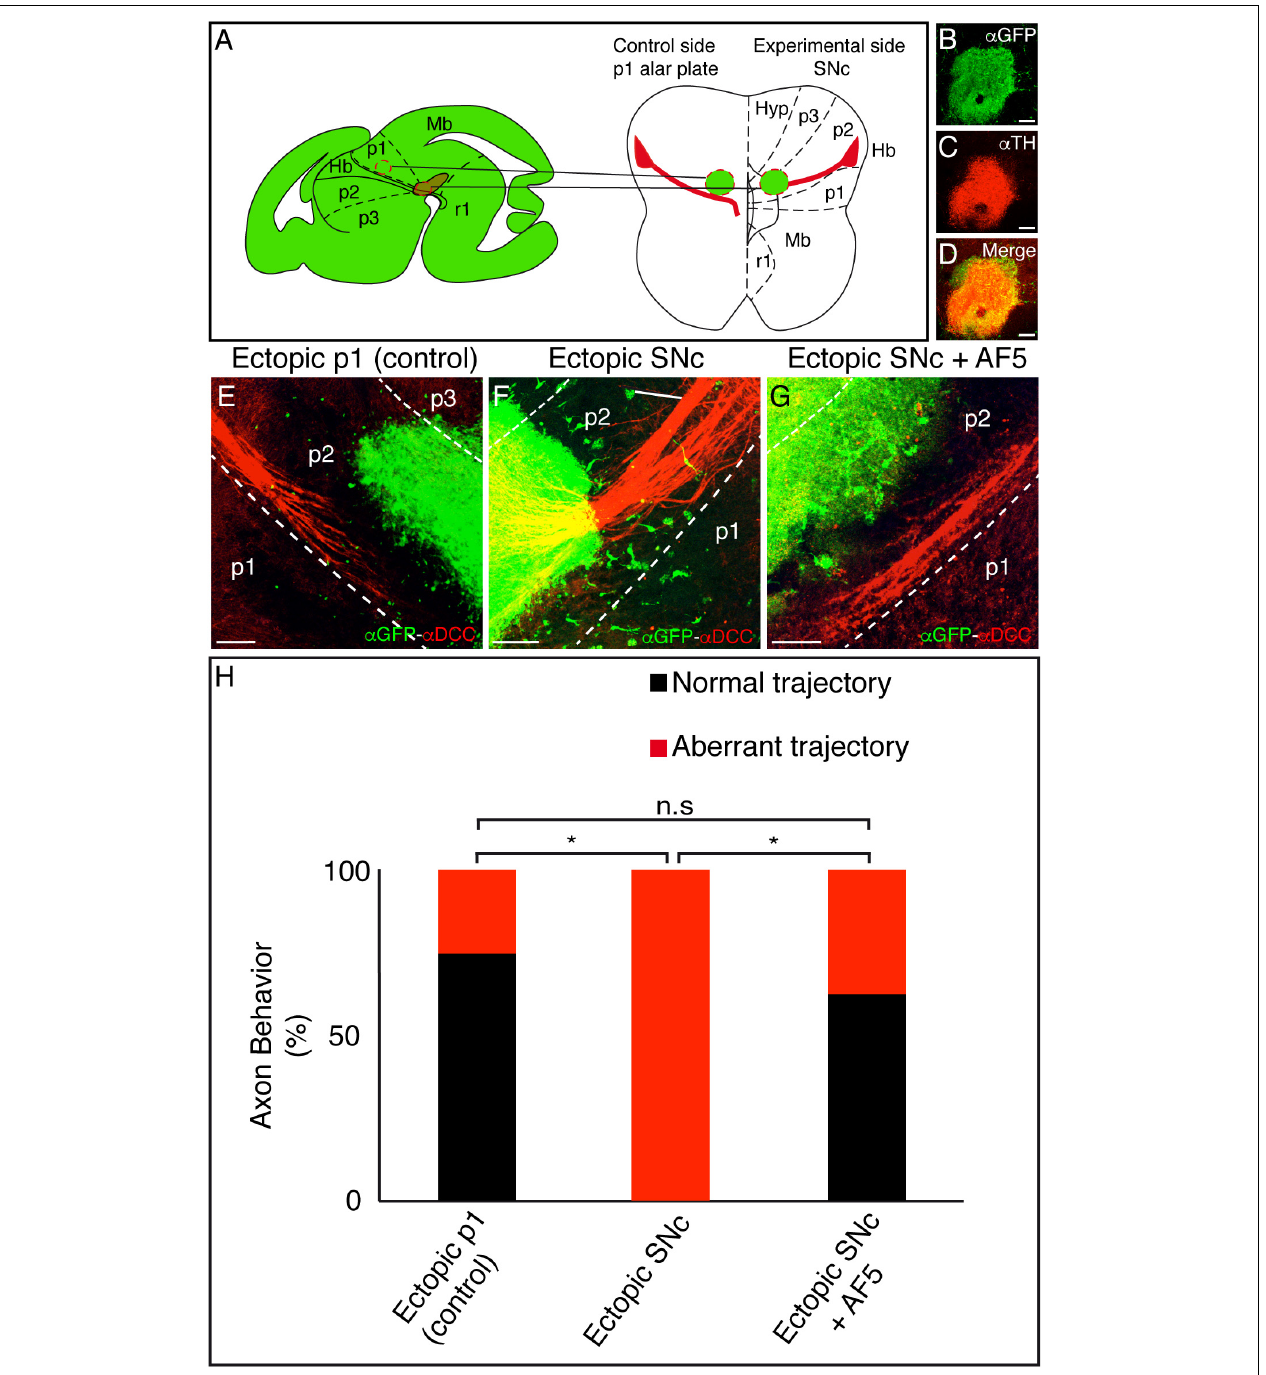
FIGURE 3 | Ectopic SNc guides the mHb axons to rostral regions. (A) Schematic representation of the ectopic tissue implantation experiment in E12.5 ONTs. The stage was selected to affect the descending fibers toward the diencephalic basal plate. The ectopic tissue is obtained from an E14.5 GFP donor. The control (p1 alar plate) and the experimental tissues (SNc) were implanted in the basal plate of the p2. Basal and floor plates are delimited by continuous lines. The floor plate is on the left and caudal to the bottom. (B–D) Characterization of the experimental ectopic tissue, labeled against GFP (B) and TH (C) to check the correct SNc isolation. D is the merged image of B and C . (E–G) Control side (E) and experimental (F) side. The ONTs with the ectopic tissue were cultured for 48 h and subjected to IHC for GFP and DCC. Placing the ectopic SNc in the ventral region of p2 reoriented the mHb axons of the fr. This effect is not observed in the control and when we implanted SNc and added the blocking DCC antibody (AF5). (H) Quantification indicating the percentage of experiments with a normal or modified trajectory mHb fr. * p < 0.01. Abbreviations: Hb, habenula; Hyp, hypothalamus; Mb, midbrain; p1, prosomere 1 (pretectum); p2, prosomere 2 (thalamus); p3, prosomere 3 (prethalamus); SNc, substantia nigra pars compacta; r1, rhombomere 1; fr, fasciculus retroflexus. Scale bar: 100 µ m.